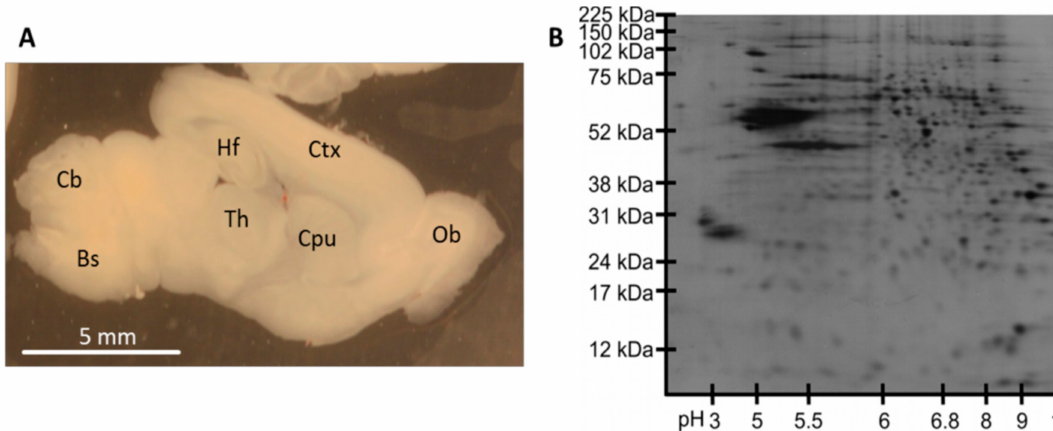
Figure 2. Protein analysis in single acute slices. ( A ) Acute slices were prepared from 5-day-old C57BL / 6 mice. Sagittally cut slices contained cortex (Ctx), hippocampal formation (Hf), thalamus (Th), caudate–putamen complex (Cpu), olfactory bulb (OB), cerebellum (Cb), and brain stem (Bs).